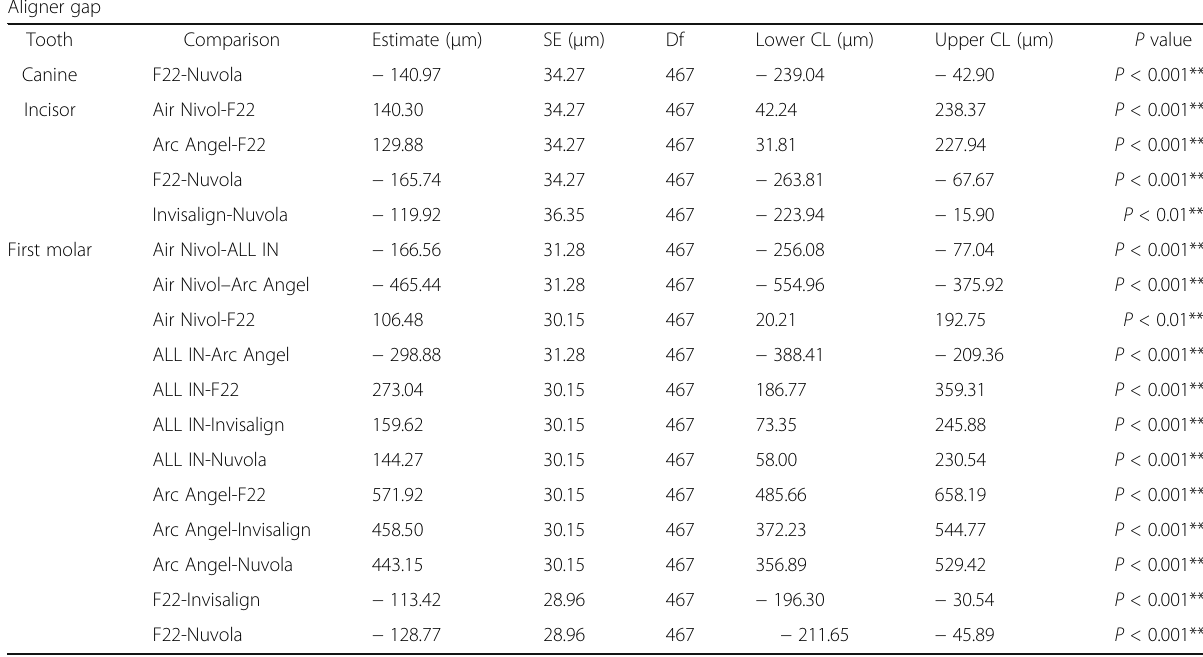
Table 4 Statistically significant comparisons for the aligner gap measure ( P < 0.05*, P < 0.01**, P < 0.001***) Aligner gap Tooth